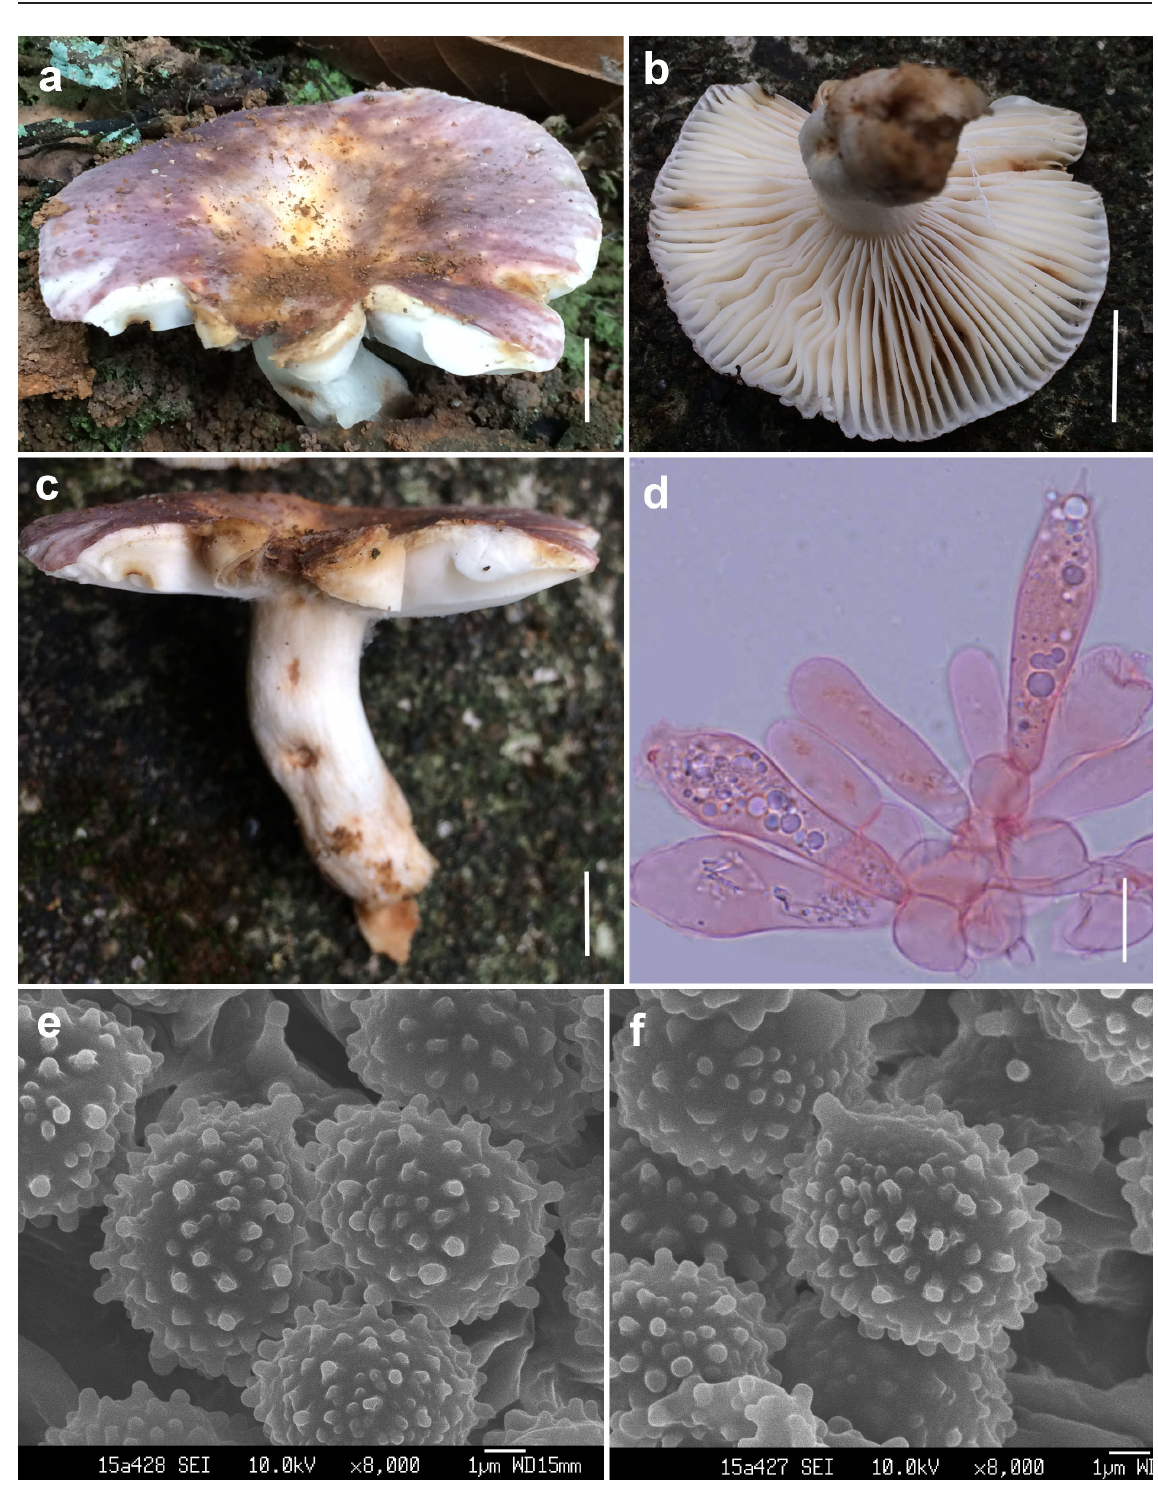
Fig. 4. Russula purpureorosea Y.Song sp. nov., holotype (GDGM75331). a–c . Fruiting bodies. d . Basidia. e–f . Basidiospores under scanning electron microscope. Scale bars: a–c = 1 cm; d = 10 μm; e–f = 1